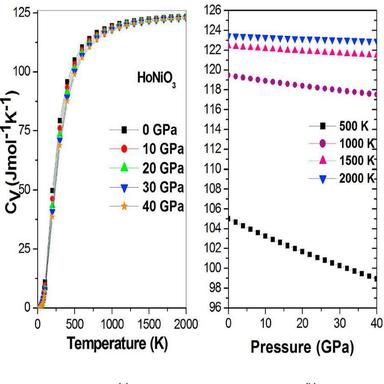
Heat capacity CV as a function of the temperature (pressure) at different given pressures (temperatures).